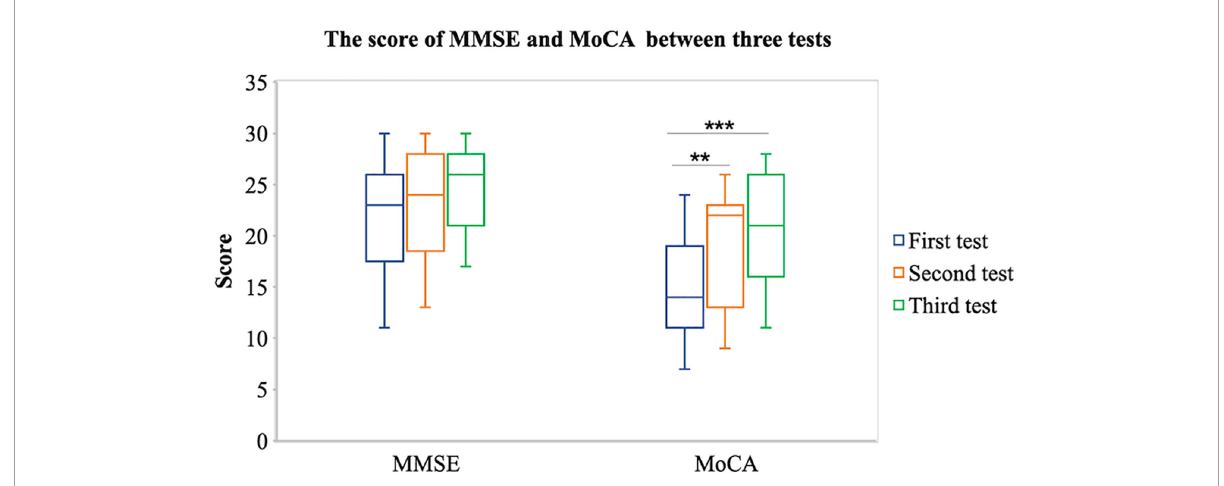
FIGURE4 Comparison of MMSE and MoCA between the first, second, and third tests. ∗∗ P < 0.05 and ∗∗∗ P <